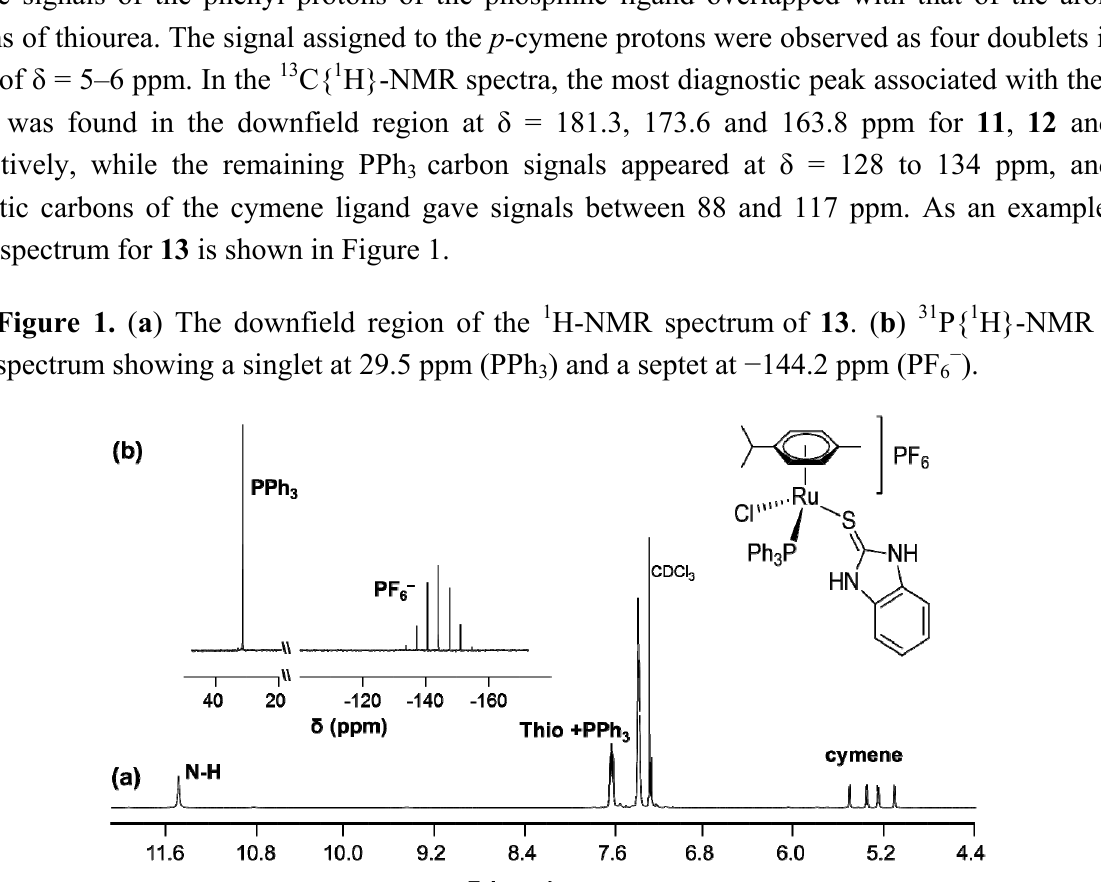
Figure 1. ( a ) The downfield region of the 1 H-NMR spectrum of 13 . ( b ) 31 P{ 1 H}-NMR spectrum showing a singlet at 29.5 ppm (PPh